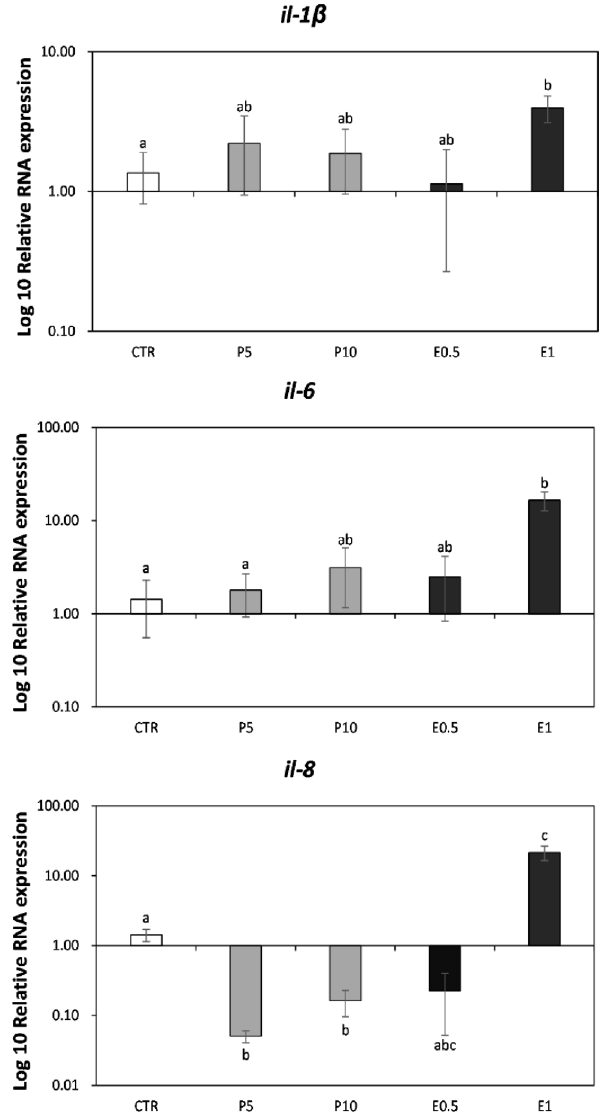
Figure 1. Relative expression of genes related to the immune system analyzed on liver of gilthead seabream. CTR: control diet (without HBP and HBP_SFE); P5 and P10: diets including 5% or 10% of honeybee pollen (HBP), respectively; E0.5 and E1: diets including 0.5% or 1% supercritical fluid extract (SFE) from HBP (HBP_SFE), respectively. Values are the mean ± SEM (n = 9). Statistical differences ( p < 0.05) between groups are indicated by the different letters (a, b,